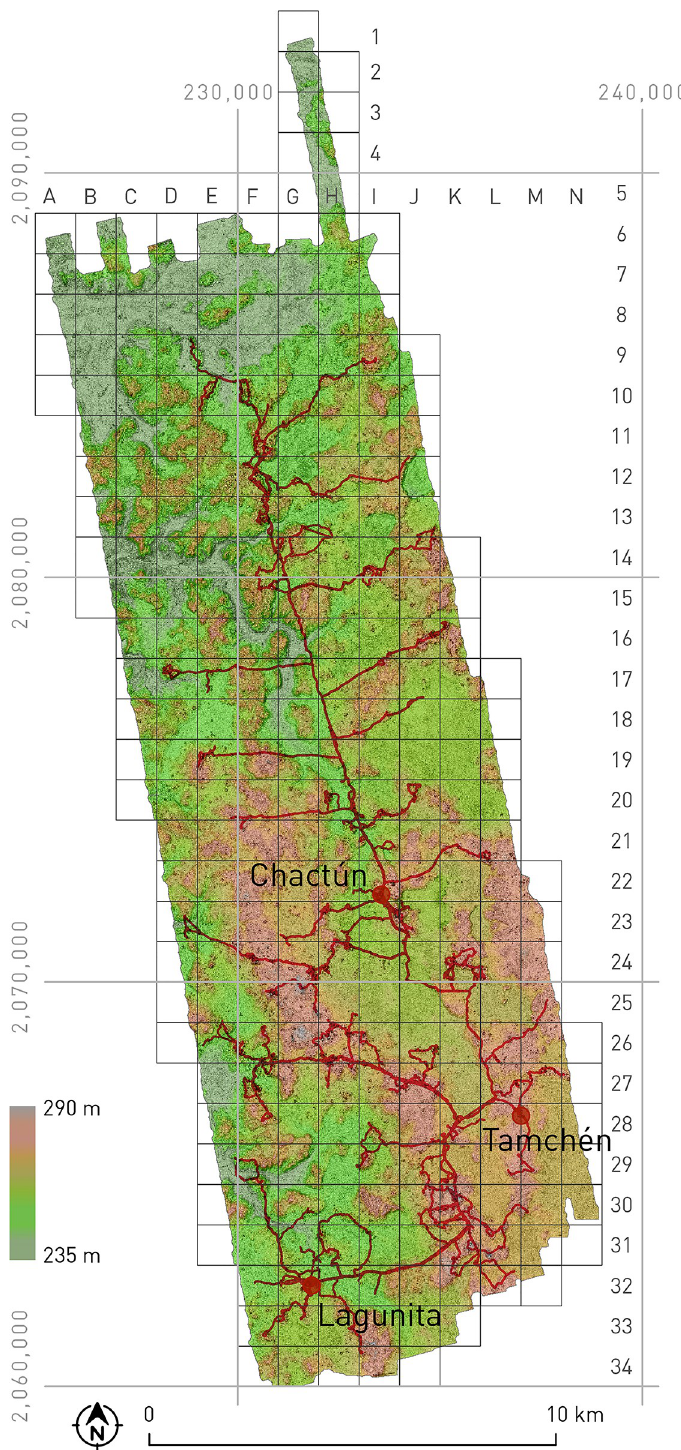
Fig 2. Visualization of the ALS-scanned CHRP area, showing the tracks followed in field surveys and the quadrants used to identify groups of archaeological vestiges.